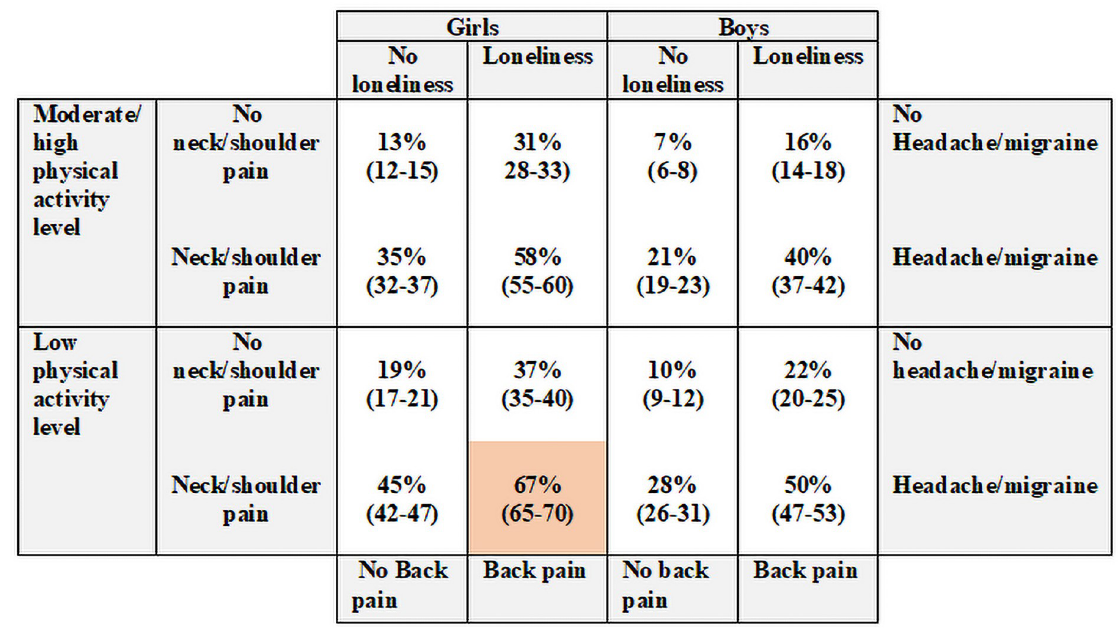
Fig 2. Risk profiles for persistent neck pain in young adulthood in Sample I (n = 1433). Sample I = all participants. Probabilities of persistent neck pain at follow-up (%, [95% CI]), red = highest risk profile.